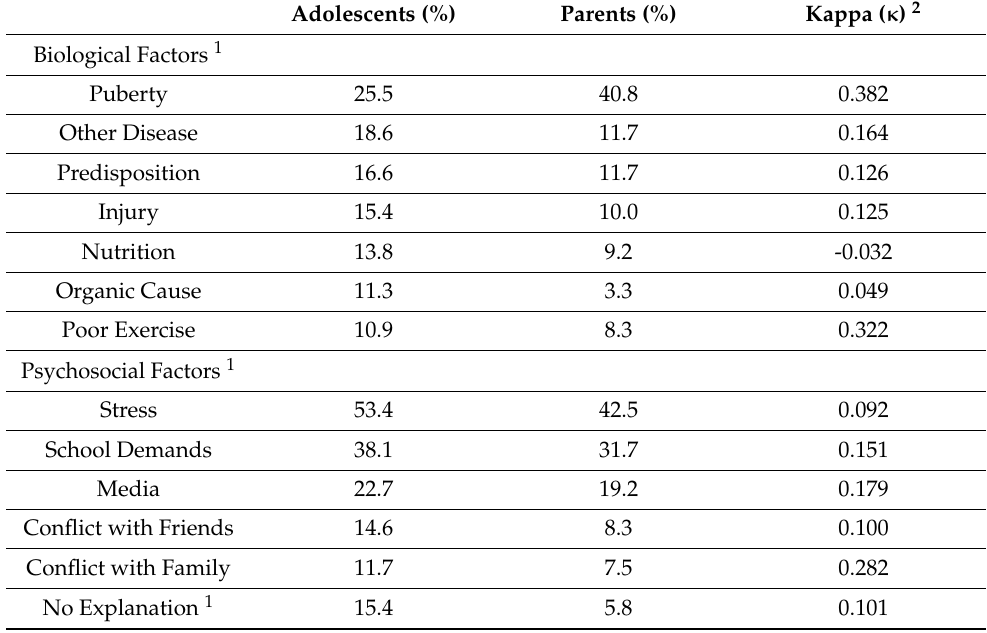
Table 1. Descriptive statistics of adolescents’ ( N = 247) and parents’ ( N = 120) judgments of potential causes of headaches.